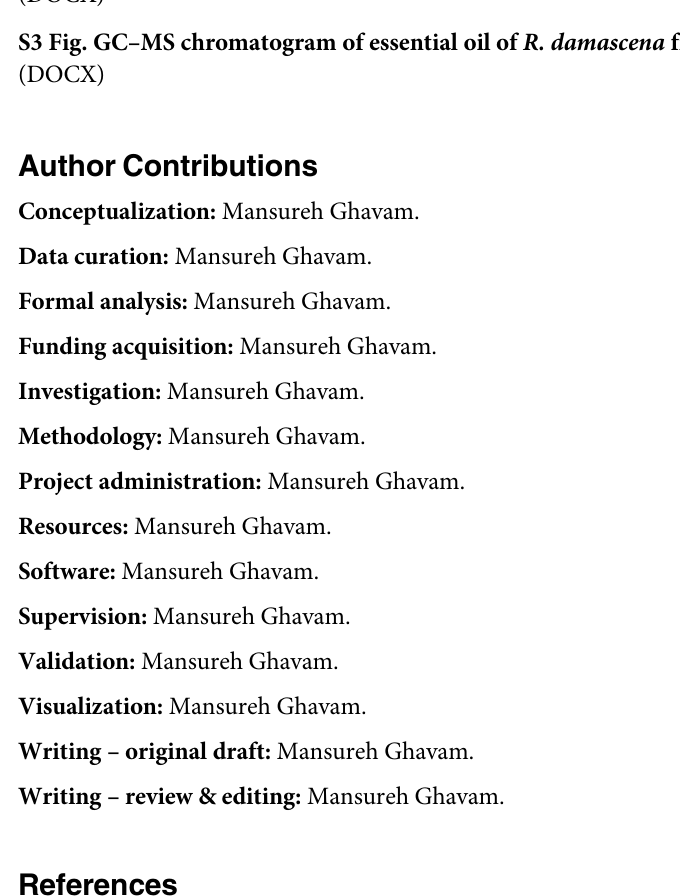
S3 Fig. GC–MS chromatogram of essential oil of R. damascena from